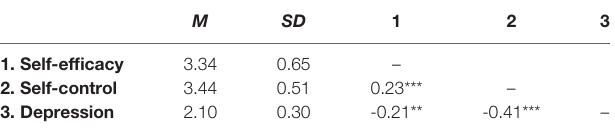
TABLE 1 | Descriptive statistics for study variables ( N =231).